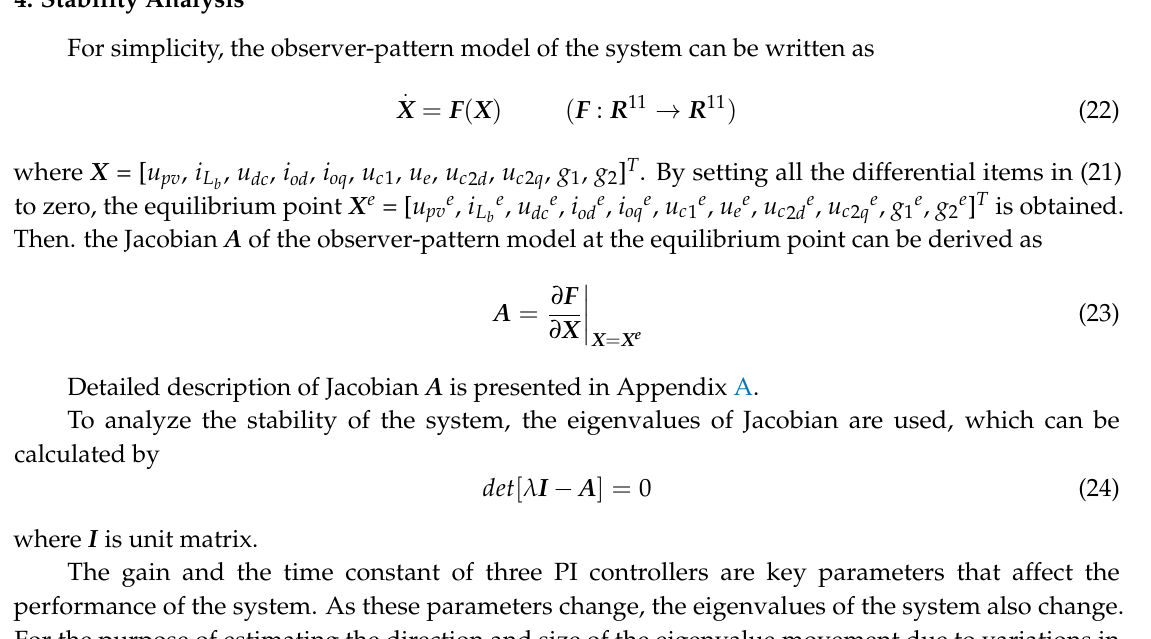
Figure 3. Output current waveform.